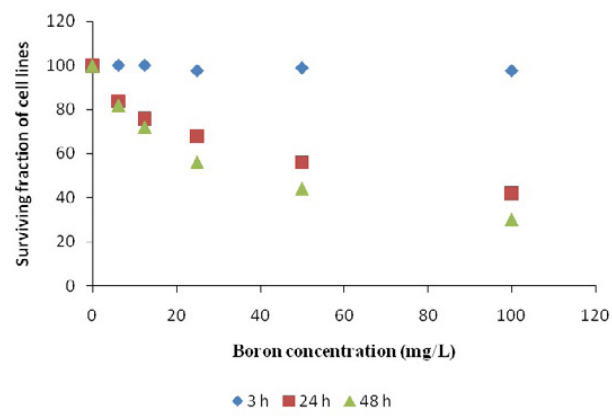
Fig. 9. Diagram of toxicity for in-vivo treatment in